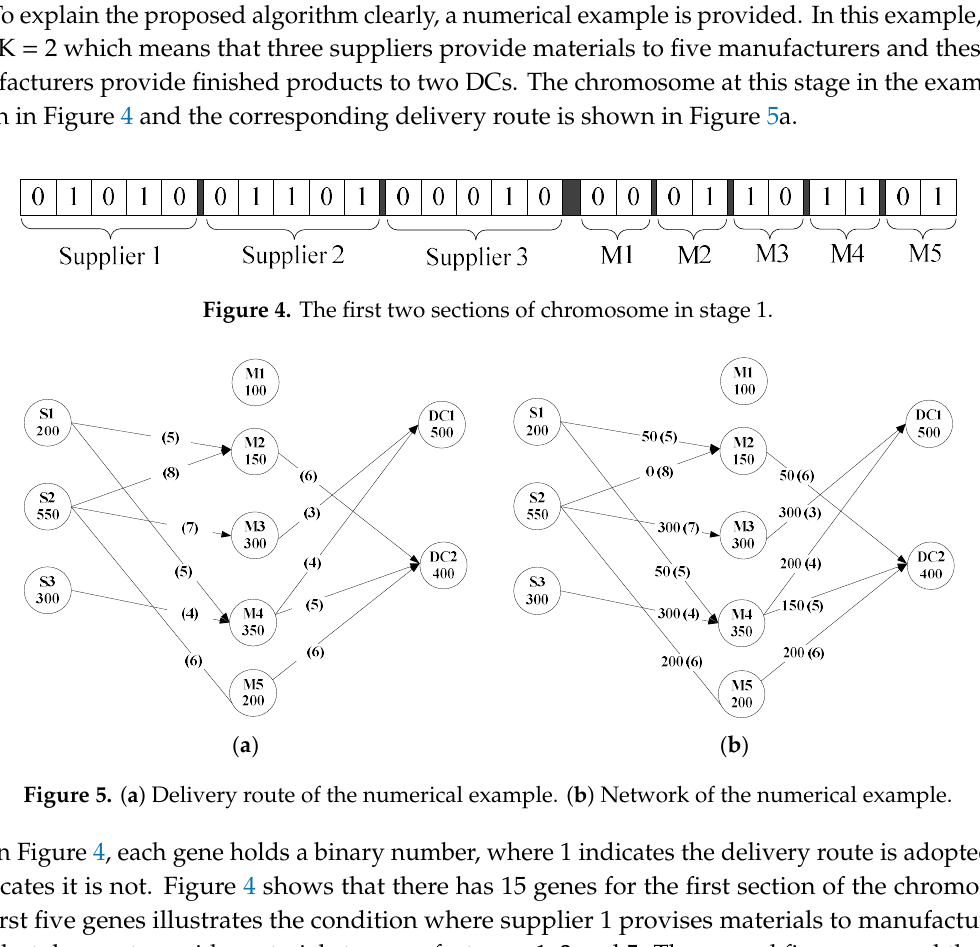
Figure 5. ( a ) Delivery route of the numerical example. ( b ) Network of the numerical example.